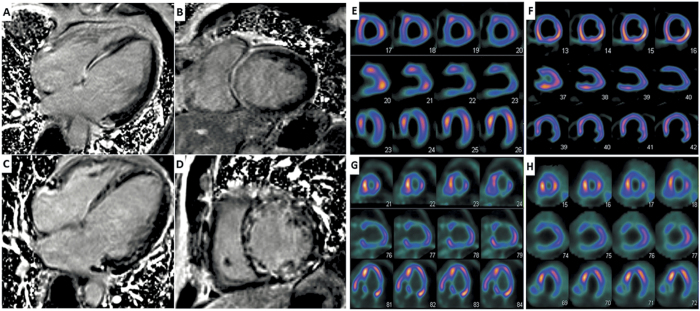
Representative examples of LGE-positive and perfusion/metabolism abnormality images.The typical LGE pattern in DCM is mid-wall enhancement in the interventricular septum (A,B). A diffuse pattern was observed in 5 out of 31 LGE-positive patients (C,D). Severely reduced uptake of 99mTc-MIBI in apex, anterior and inferior wall (E) while 18F-FDG PET imaging showed normal FDG uptake (F) in corresponding areas, which was defined as a perfusion/metabolism mismatch pattern. Reduced uptake in anterior, mildly to moderately reduced uptake in lateral and inferior wall in both 99mTc-MIBI SPECT (G) and 18F-FDG PET imaging (H), which was defined as a severe perfusion/metabolism match pattern in anterior and mild-to-moderate match pattern in lateral and inferior wall.